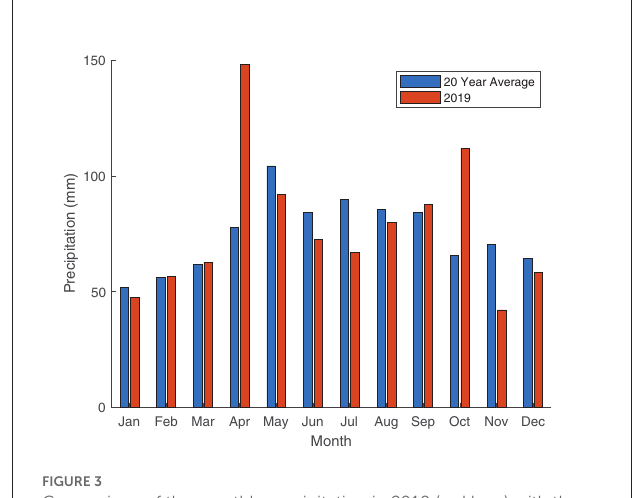
FIGURE3 Comparison of the monthly precipitation in 2019 (red bars) with the 2000–2019 mean (blue bars) for Detroit.